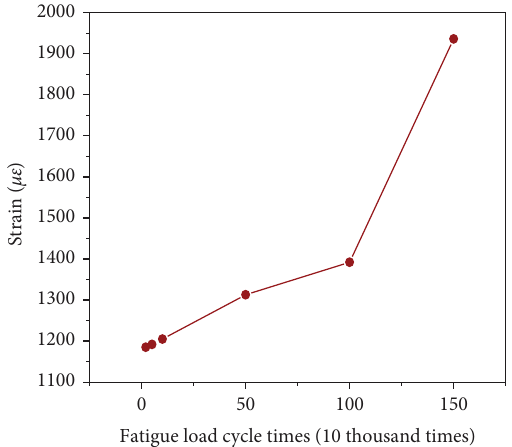
Figure 6: Te relationship between the steel strain and the number of fatigue load